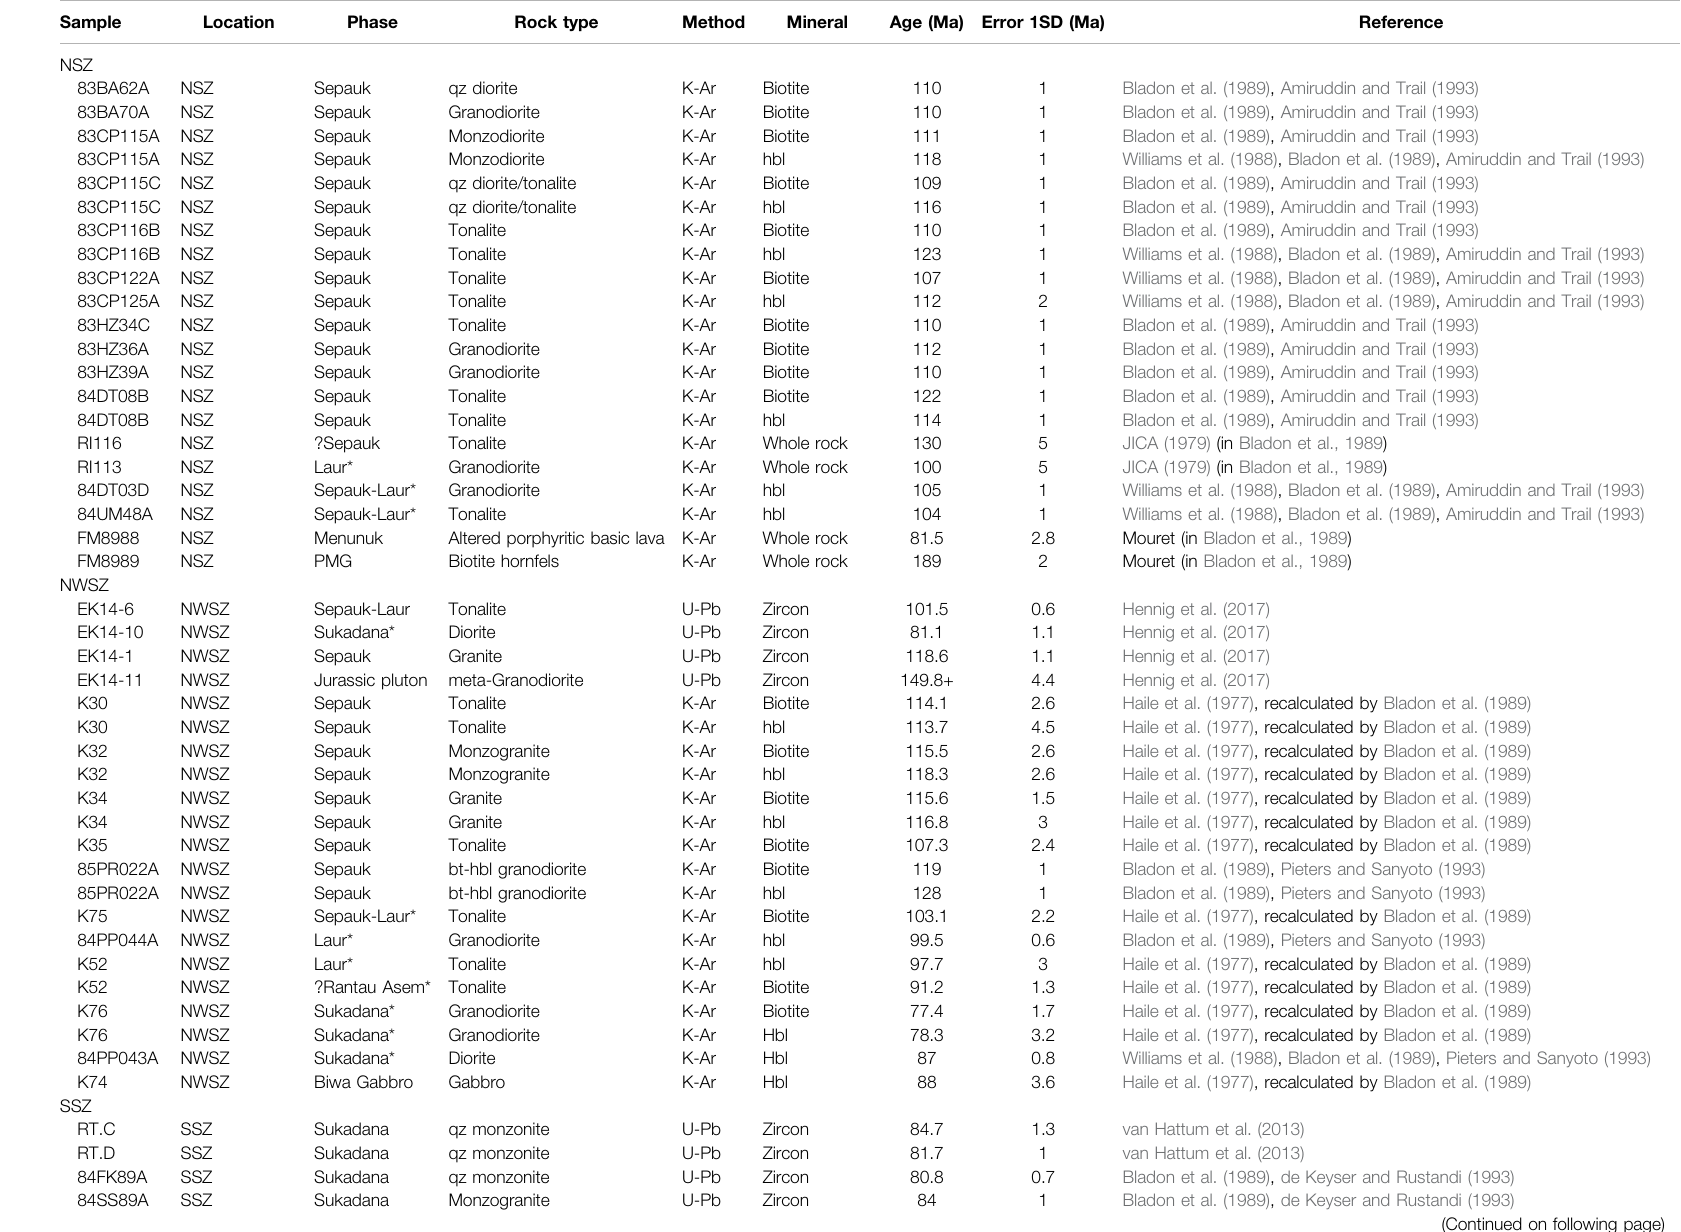
TABLE 1 | Literature age data of Jurassic to Cretaceous rocks of the Schwaner Mountains and western Borneo. Phases marked with * are here reinterpreted based on their ages compared to their original